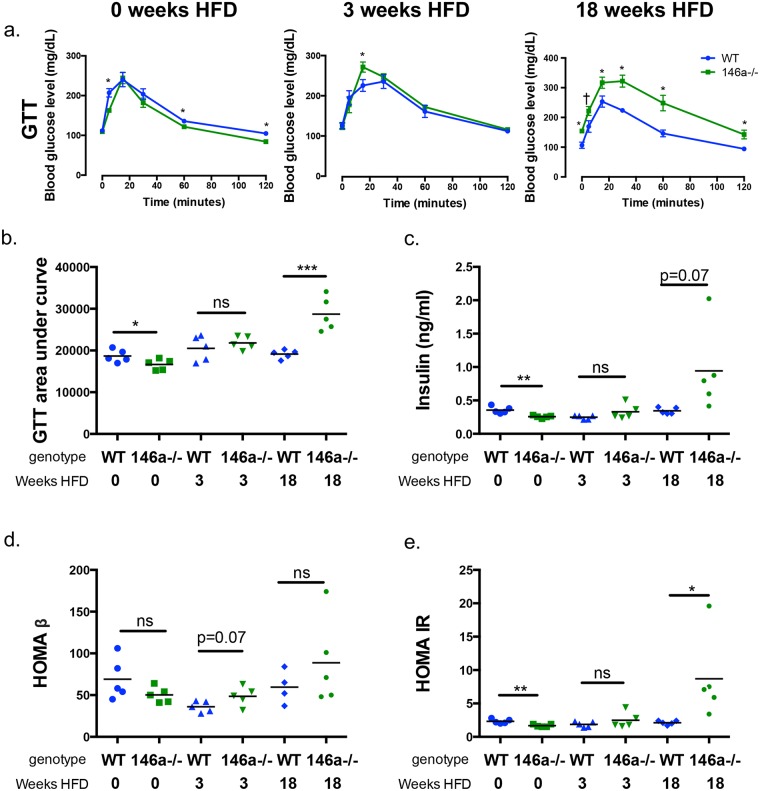
miR-146a is required for protection from a diabetic phenotype during diet-induced obesity.All measurements were performed in WT (blue) and miR-146a-/- (green) mice at 0, 3, and 18 weeks HFD. (A) GTTs measuring blood glucose levels, following injection of glucose at 0 minutes and measured over time for 120 minutes. (B) Area under curve of GTTs. (C) Serum insulin levels, measured via ELISA. (D) HOMA-β levels, measuring beta cell function. (E) HOMA-IR levels, measuring insulin resistance. Data are shown as mean ± SEM (a) or as individual mice (b-e) (n = 5). p-value was calculated using two-tailed Student’s t-test. *p<0.05; **p<0.01; ***p<0.001; ns = not significant. See also S3 Fig.